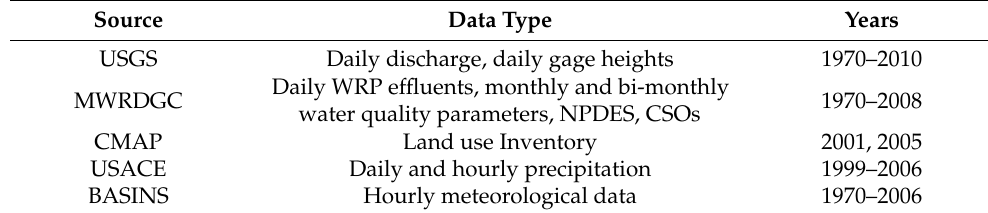
Figure 1. Data sources and locations used in the model. Table 1. Description of data sources used in the model